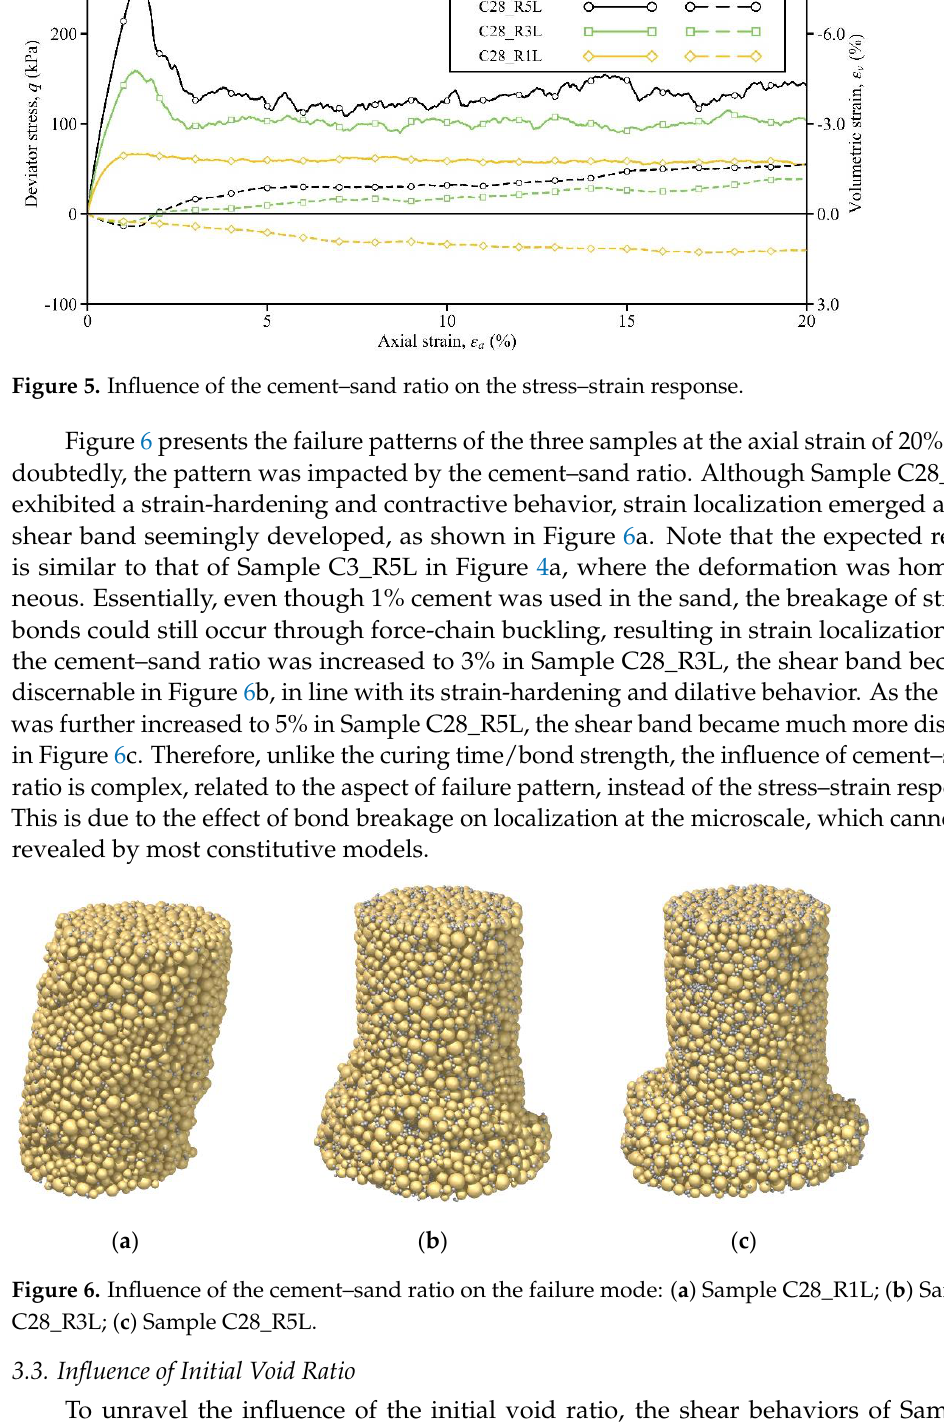
8 of 14 Figure 4. Influence of the curing time on the failure mode: ( a ) Sample C3_R5L; ( b ) Sample C7_R5L; ( c ) Sample C28_R5L. 3.2. Influence of Cement – Sand Ratio Responses of Samples C28_R1L, C28_R3L, and C28_R5L are discussed in this section to understand the influence of the cement – sand ratio on the shear behavior of the ce- mented sand. Figure 5 depicts the stress – strain responses of these three samples. Similar to the effect of increasing the curing time, the peak/residual strength and the pre-peak stiffness could also be enhanced by increasing the cement – sand ratio. In Sample C28_R1L with a ratio of 1%, although the cement was cured for 28 days, a strain-hardening and contractive behavior seemingly appeared, with a peak stress of only 60 kPa; that is, little improvement was produced by the cementation (see the orange lines in Figure 5). The same observation was also found in the laboratory tests of Li et al. [11]. Then, upon in- creasing the cement – sand ratio from 1% to 3% in Sample C28_R3L, the bond number was increased from 5246 to 17,106, as given in Table 2. Due to this fundamental change at the